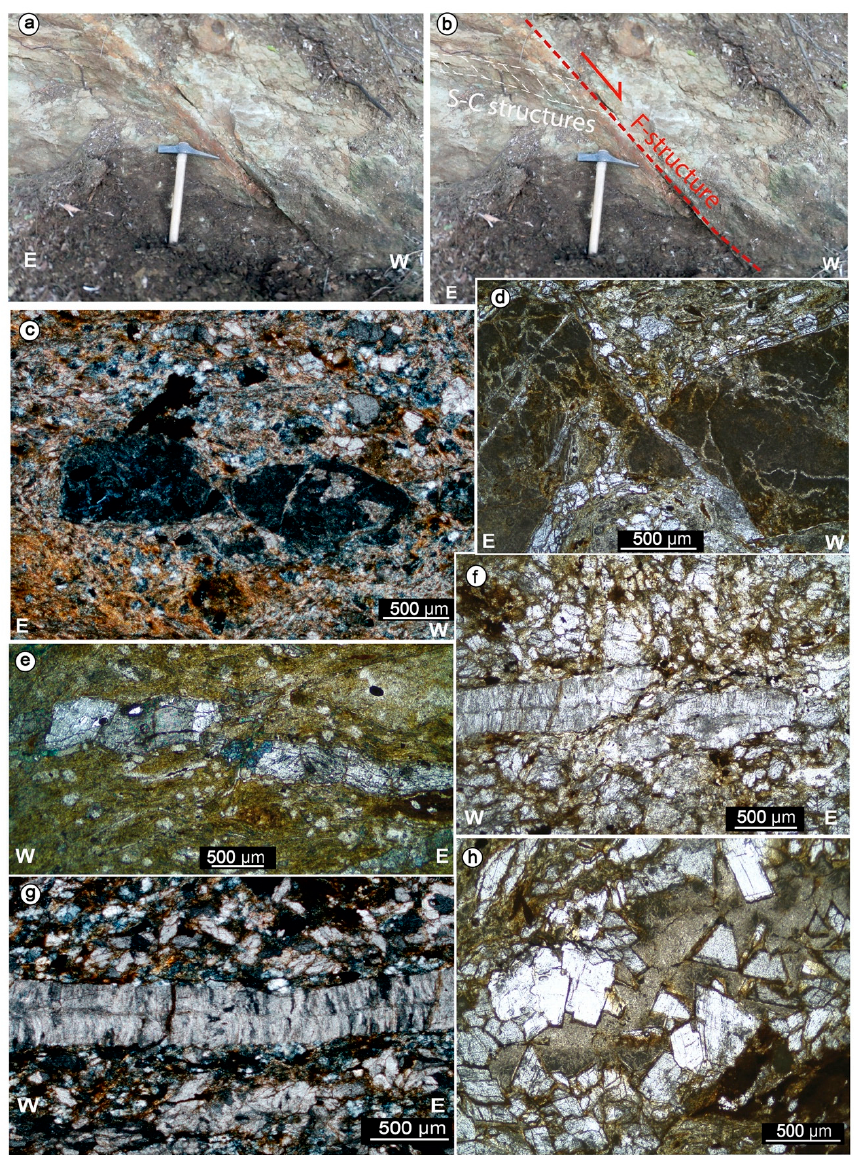
Figure 11. Brittle structures in the quartzo-feldspathic rocks. ( a , b ) West dipping faults dissecting the S/C structures and its corresponding line-drawing; ( c , d ) micrographs showing lithic porphyroclasts cross cut by small scale faults (crossed nicols); in ( d ) the porphyroclast is also wrapped by magnesite ribbons; ( e ) magnesite vein affected by fractures; ( f , g ) micrographs of fibrous, antitaxial extensional calcite; ( h ) blocky magnesite.